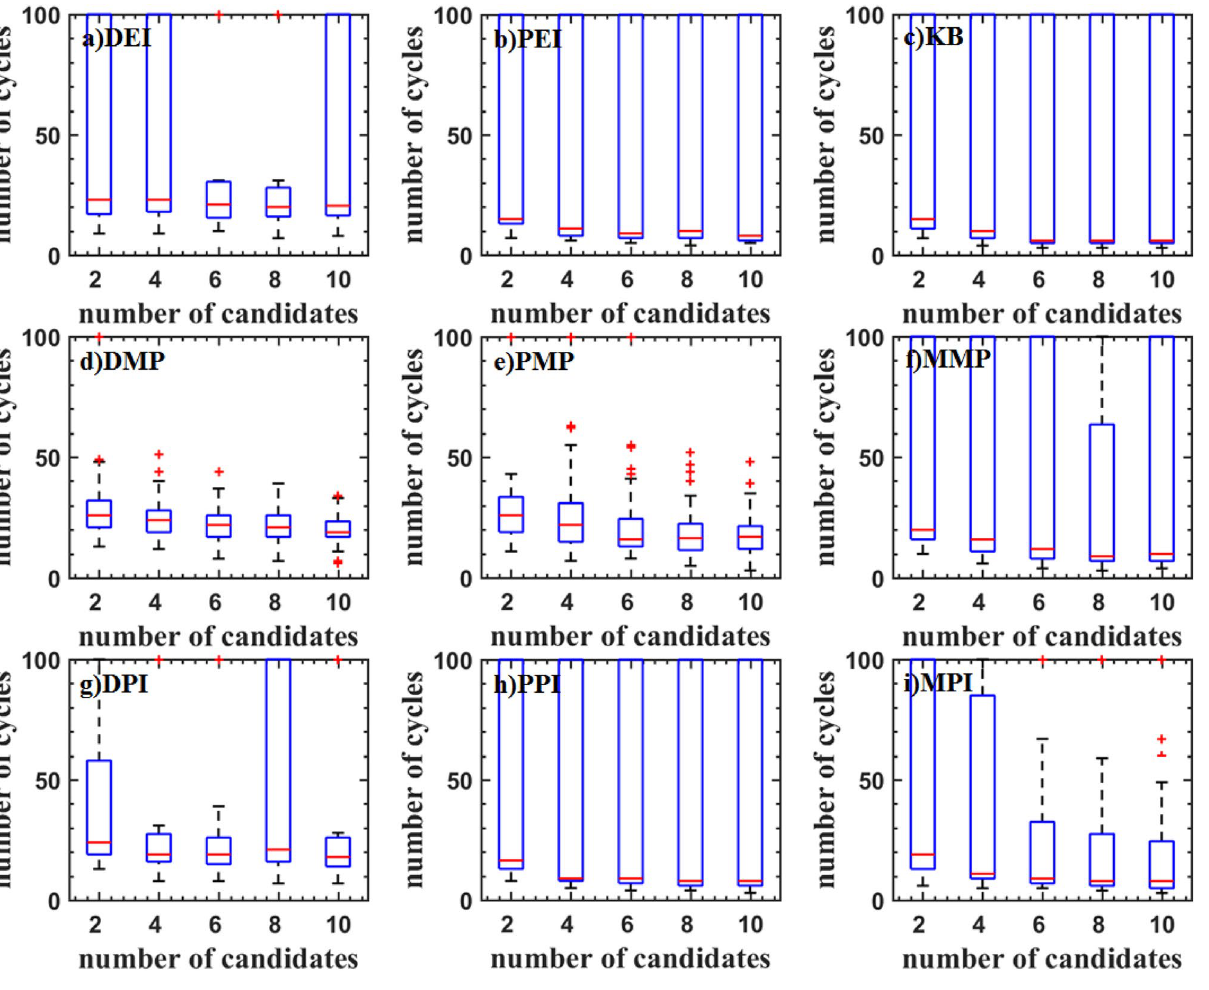
Figure 8. Test problems: Hartman6